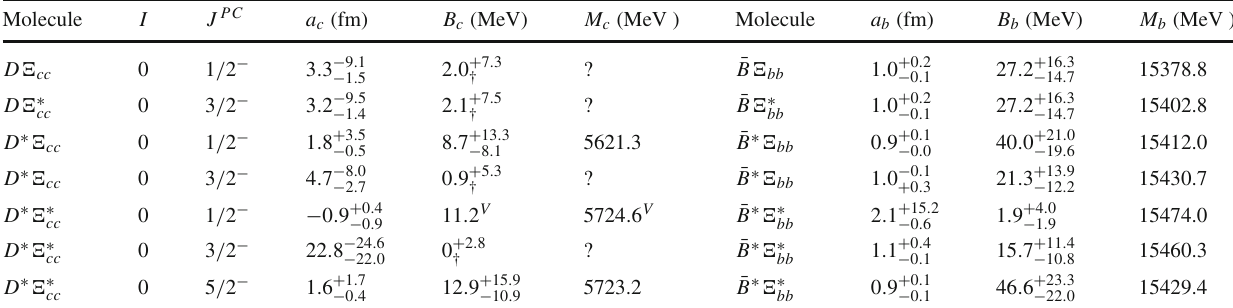
Table 4 Scattering lengths ( a in fm), binding energies ( B in MeV, if bound states exist) and mass spectra ( M in MeV) of prospective isoscalar heavy meson–baryon molecules. The superscript V denotes the existence of virtual states, the † symbol denotes that the system is unbound, and the ? symbol indicates that the system is bound with the